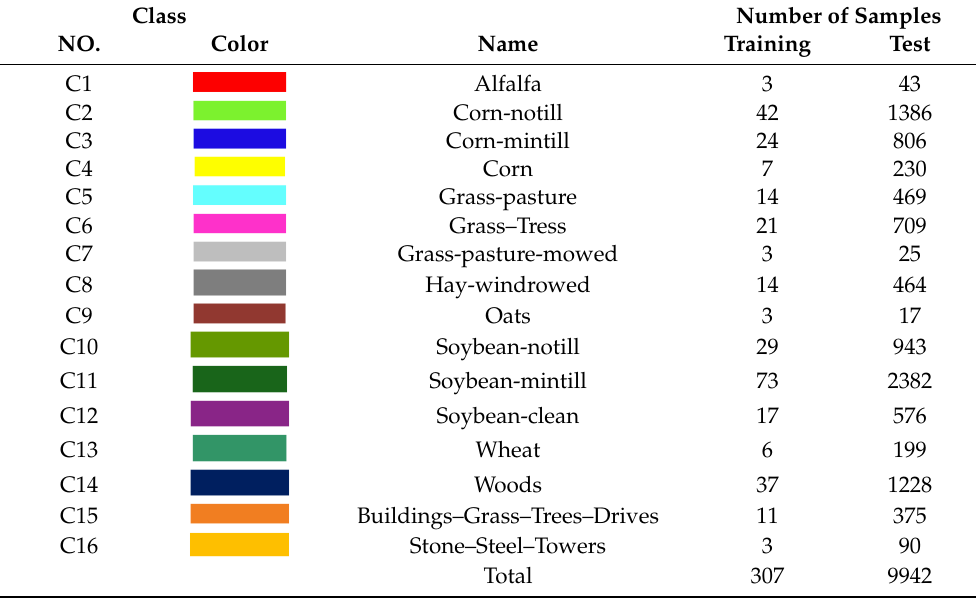
Table 1. Number of training samples and test samples in IN data set.